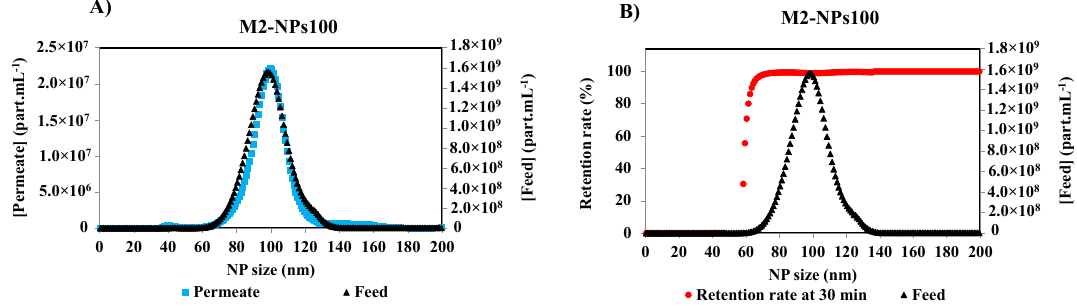
Figure 5. ( A ) Particle size distribution of the feed and the permeate of NPs100 at 30 min of the filtration process with membrane M2, and ( B ) associated retention rate at 30 min of filtration of M2-NPs100 [Room temperature, TMP ~0.5 bar].